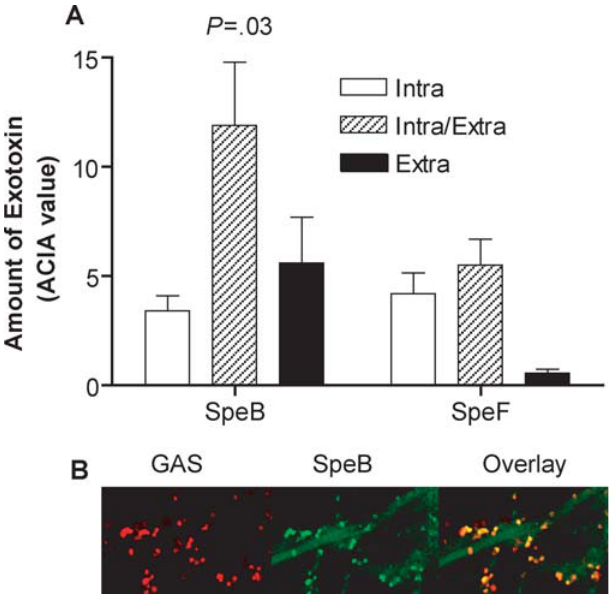
Figure 3. Amount of Spe in Tissue Biopsies with Different Bacterial Localization Tissue biopsies were immunohistochemically stained for GAS, SpeB, and SpeF, and the stainings were quantified by ACIA. (A) Amount of SpeB and SpeF in biopsies with different bacterial localization ( n ¼ 65 and 67, respectively); Intra, intracellular; Intra/Extra, intra and extracellular; and Extra, extracellular. Bars show mean 6 SEM. Statistically significant differences were estimated by a Kruskal-Wallis median test. (B) SpeB attached to the bacterial cell surface in a representative tissue biopsy. Confocal microscopy of immunostainings of GAS (Alexa 546, red) and SpeB (Alexa 488, green). Colocalized staining is shown in yellow. DOI: